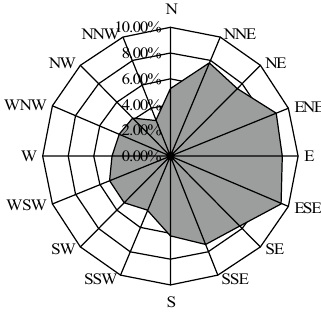
Figure 3. Wind rose diagram of wind direction. The wind direction is divided into 16 different sections. In the range from the direction N clockwise to S, three are seven main wind directions with 57.54% frequency totally. The other directions show an approximately uniform dispersion.